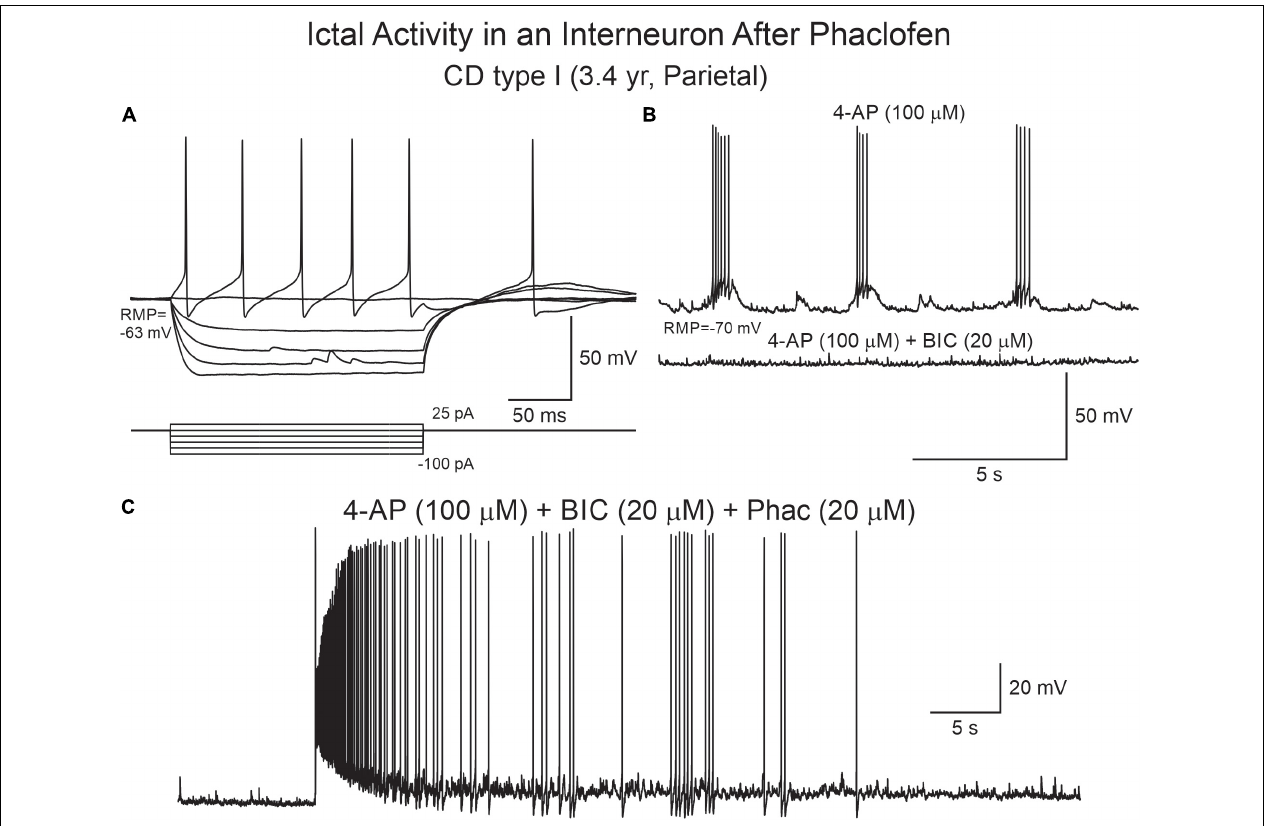
FIGURE 10 | Phaclofen induces ictal-like activity in cortical interneurons. (A) Current clamp recording of a cortical interneuron from a CD type I case. Depolarizing current pulses induced action potentials with very large after-hyperpolarization. (B) After 4-AP, rhythmic depolarizations and bursting were induced. Addition of BIC almost completely eliminated bursting. (C) Addition of phaclofen to the mix resulted in ictal-like discharges.